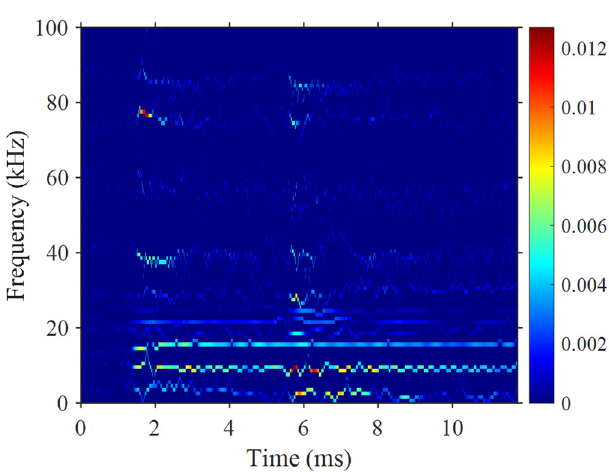
Figure 11. Time–frequency spectrum obtained by EWT–HT based on STFT and closing operation.